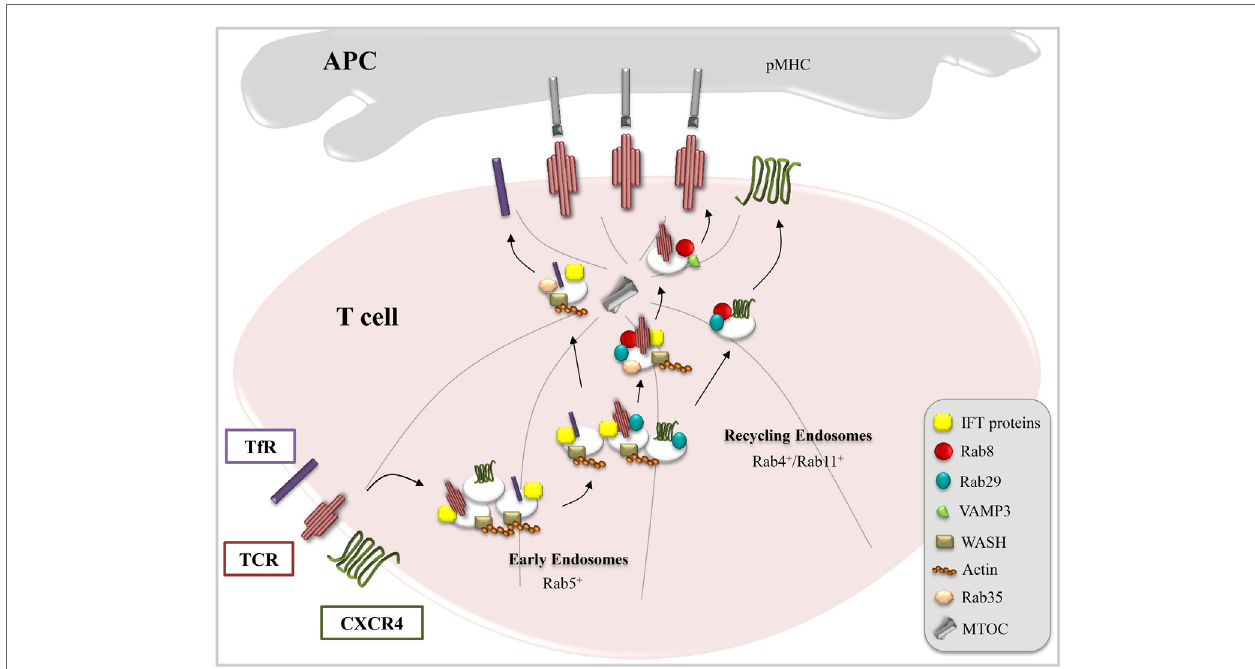
FiGURe 1 | Combinatorial usage of trafficking regulators in receptor targeting to the iS . T cell activation requires IS delivery of receptors (e.g., TCR, TfR, and CXCR4) and membrane-associated signaling mediators (e.g., Lck and LAT) associated with endosomal pools. This is achieved through tailor-made trafficking pathways characterized by unique combinations of common (Rab5, Rab4, and Rab11) and specific (IFT proteins, Rab8, Rab29, VAMP3, WASH, and Rab35) endosomal regulators, as exemplified here for TCR, TfR, and